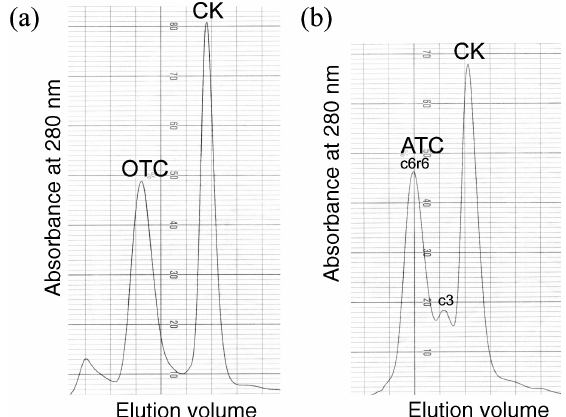
Figure 1. Small zone gel filtration chromatography. (a) Elution of a mixture of 50 µM carbamate kinase (CK) (12.3 ml) and 8.3 µM orni- thinecarbamoyl phosphate (OTC) (9.8 ml). (b) Elutionof a mixtureof 50 µM CK (12.7 ml) and 16.7 µM aspartate carbamoyltransferase (ATC), c6r6 holoenzyme, c3 catalytic trimer (10.5 ml). Samples of 100 µl were injected on a Superose 12 (APB) column equilibrated with 20 mM Tris-HCl, pH 8.0, 100 mM